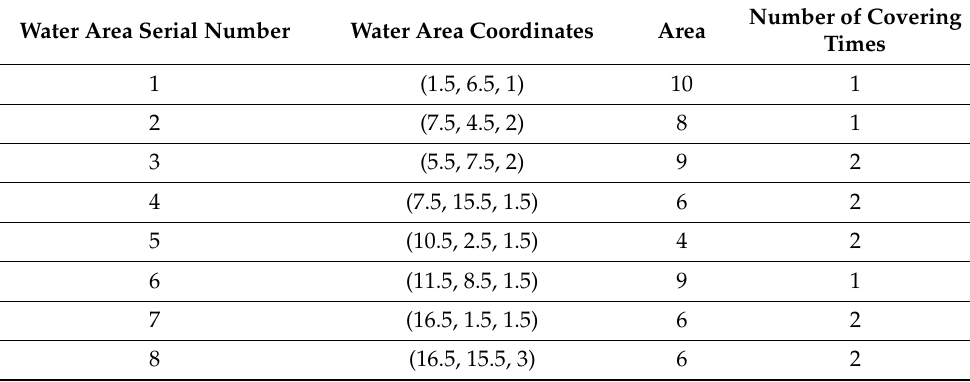
Number of Covering